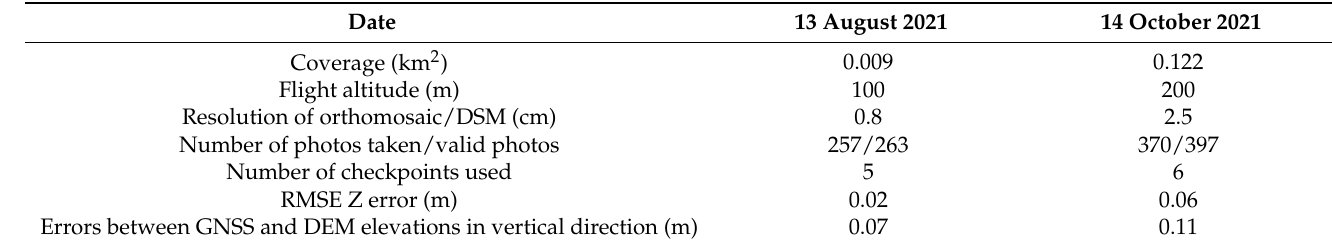
Figure 4. Orthomosaic on 13 August 2021 and 14 October 2021 at DG17. The geotextile borders are indicated with red boxes, while the blue squares indicate the checkpoints. Table 2. Details of the UAV coverage area, flight-related information, and UAVs’ error during the flight over